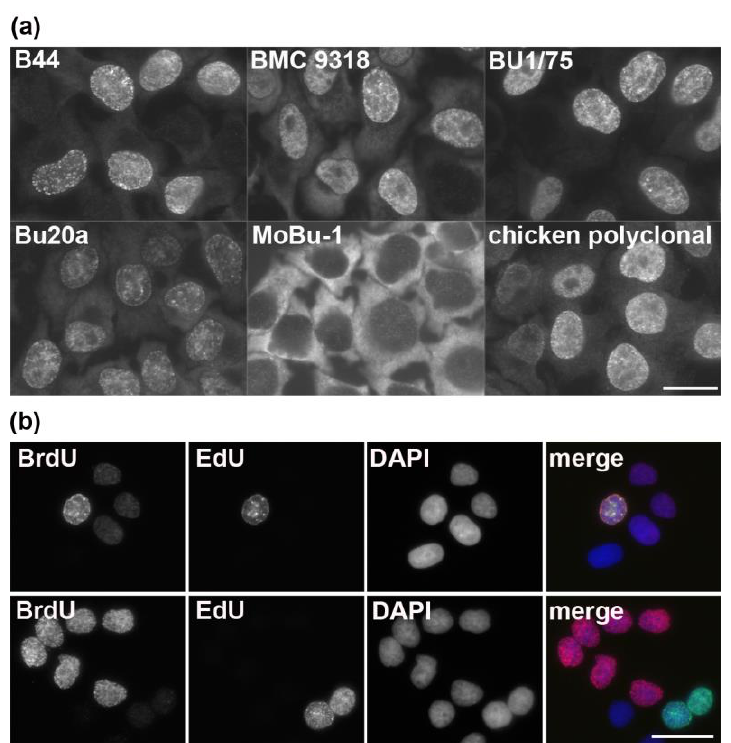
Figure 7. The detection of EdU in fixed HeLa cells and the simultaneous localization of BrdU and EdU. ( a ) The picture shows examples of the detection of EdU in fixed and permeabilized cells with six anti-BrdU antibodies after a ten-minute EdU labeling pulse. Note that only the clone MoBu-1 exhibits no signal. Bar: 20 µm. ( b ) The results of simultaneous localization of BrdU and EdU of cells labeled for 5 min with BrdU and then after 13 h for 20 min with EdU is shown. The upper set of images represents the detection of both signals without the application of the blocking step by means of 2 mM of azidomethylphenylsulfide. The bottom set of images represents the detection of both signals with the application of the blocking step by means of 2 mM of azidomethylphenylsulfide. Bar: 20 µm. Adapted with permission from Liboska et al., 2012, PLoS ONE 7(12): e51679 [100].